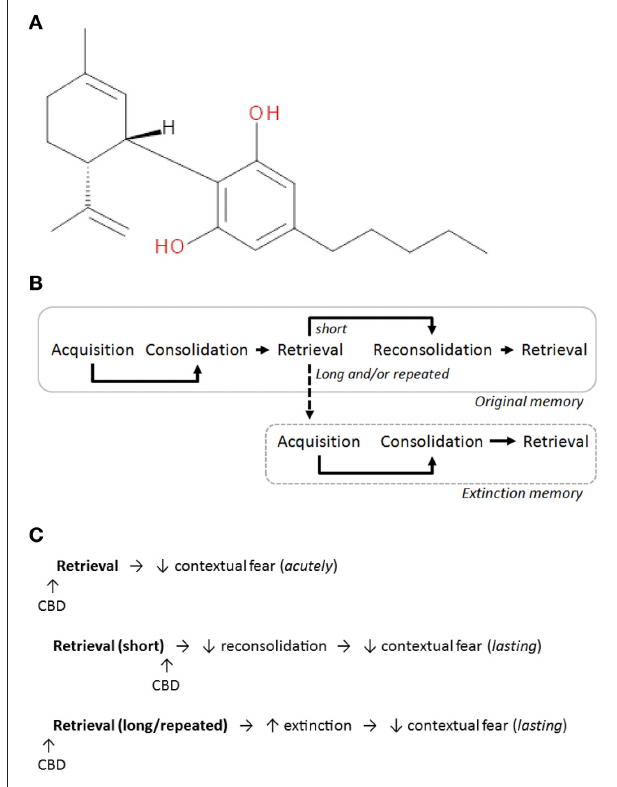
FIGURE 1 | (A) The chemical structure of CBD (National Center for Biotechnology Information, 2016). (B) The different phases of fear memory. In the hours after its acquisition fear memory undergoes consolidation. After a short duration of retrieval, fear memory can become destabilized, after which it undergoes reconsolidation to maintain or update the memory. With longer retrieval and/or repeated exposures extinction can occur, resulting in the acquisition and consolidation of a new extinction memory which competes with the original memory to inhibit fear expression. (C) A summary of the effects of acute CBD administration on different contextual fear memory processes. CBD reduces learned fear expression, disrupts fear memory reconsolidation, and facilitates fear